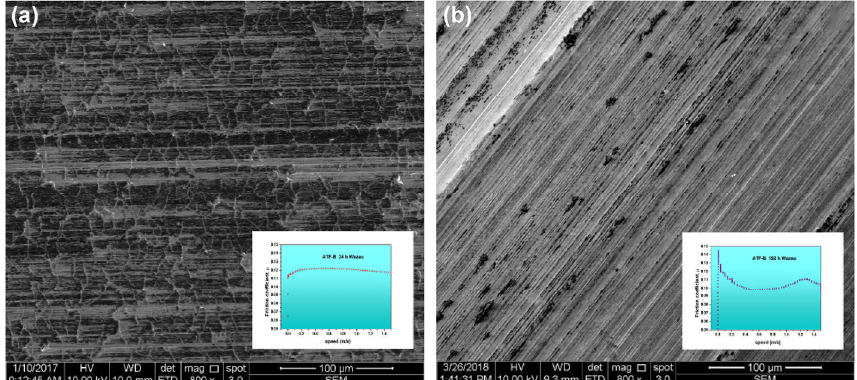
Fig. 4 SEM images of post-test steel disc surfaces after (a) 24 h and (b) 192 h Wazau durability tests for ATF-B.